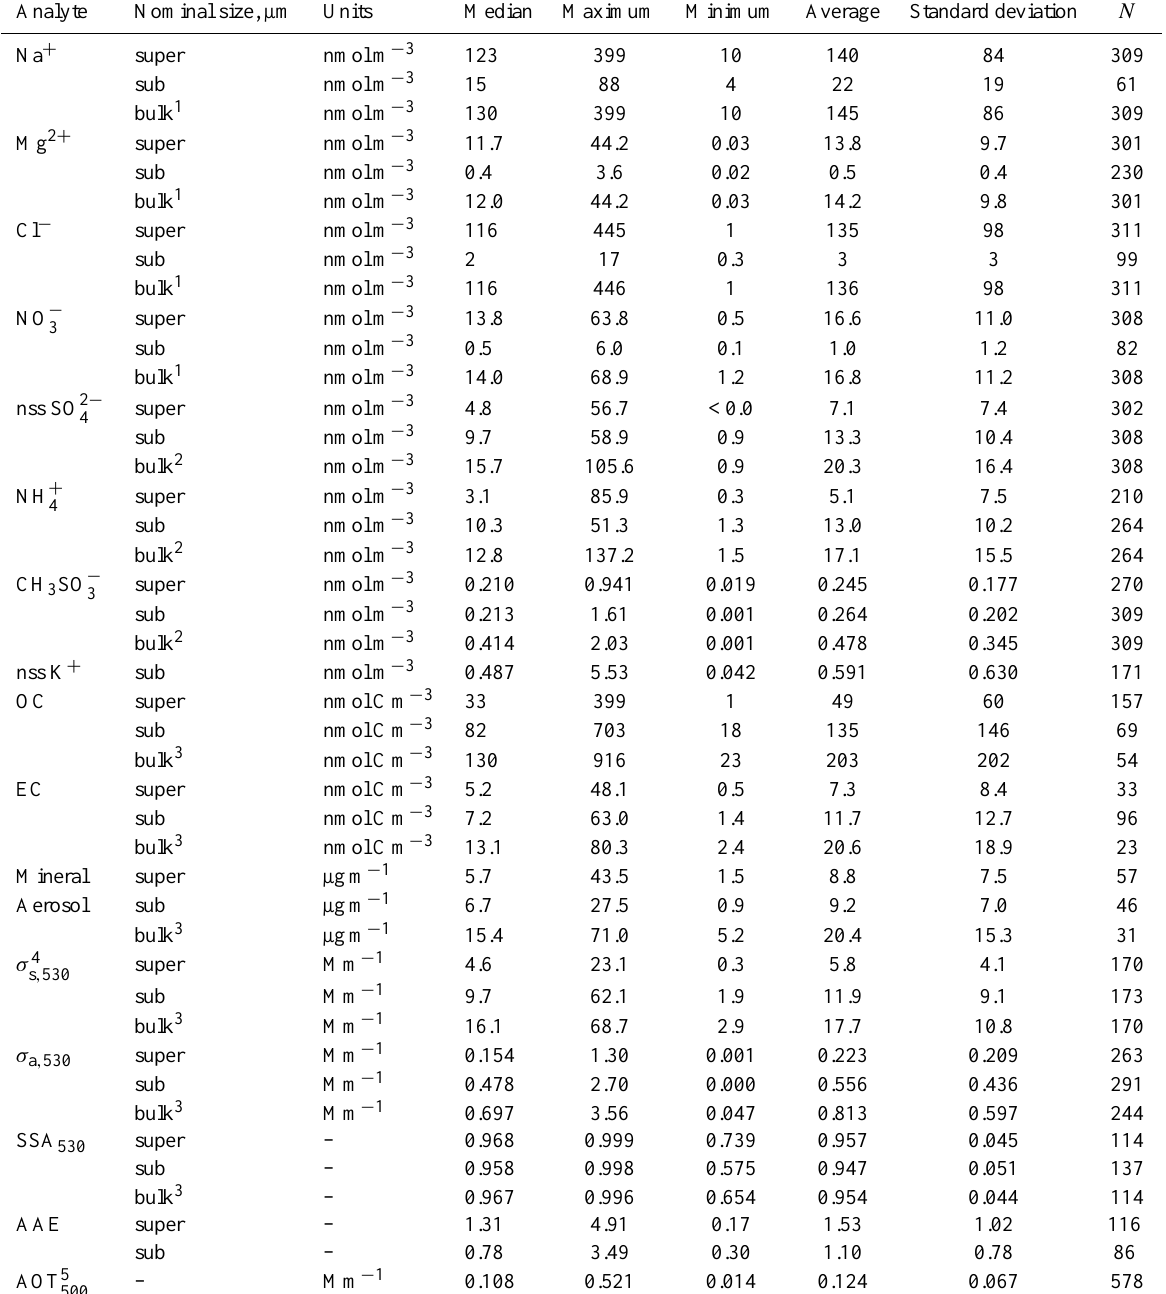
Table 1. Summary statistics for selected aerosol properties based on measured measured values